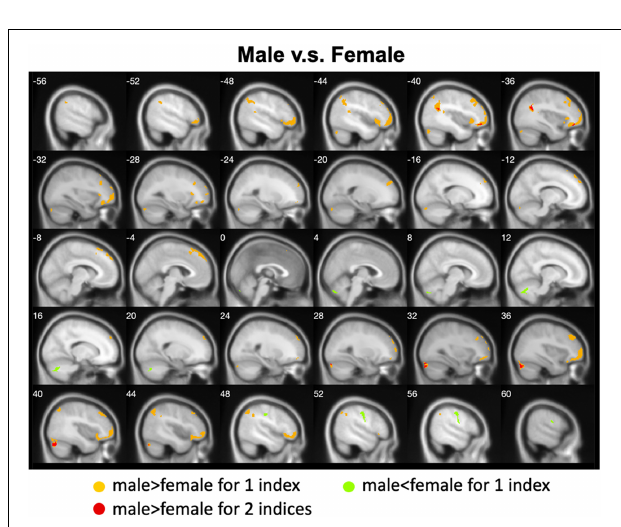
FIGURE 5 | Overlapped regions that showed different global brain connectivity (i.e., DC and rsFC of PCC) between males and females. Light red indicates common regions for the two indices where the males exhibited significantly higher rsFC than the